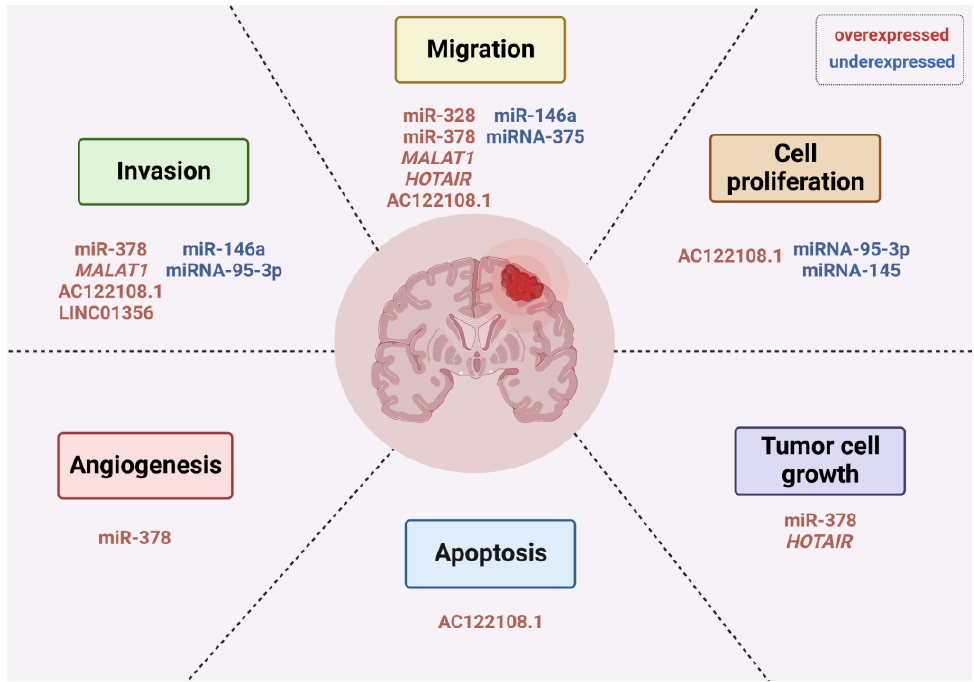
Figure 2. Non-coding RNAs (ncRNAs) and their roles in the hallmarks of cancer implicated in the development of BM from lung cancer. Red color indicates overexpressed ncRNAs; blue color indicates underexpressed ncRNAs.